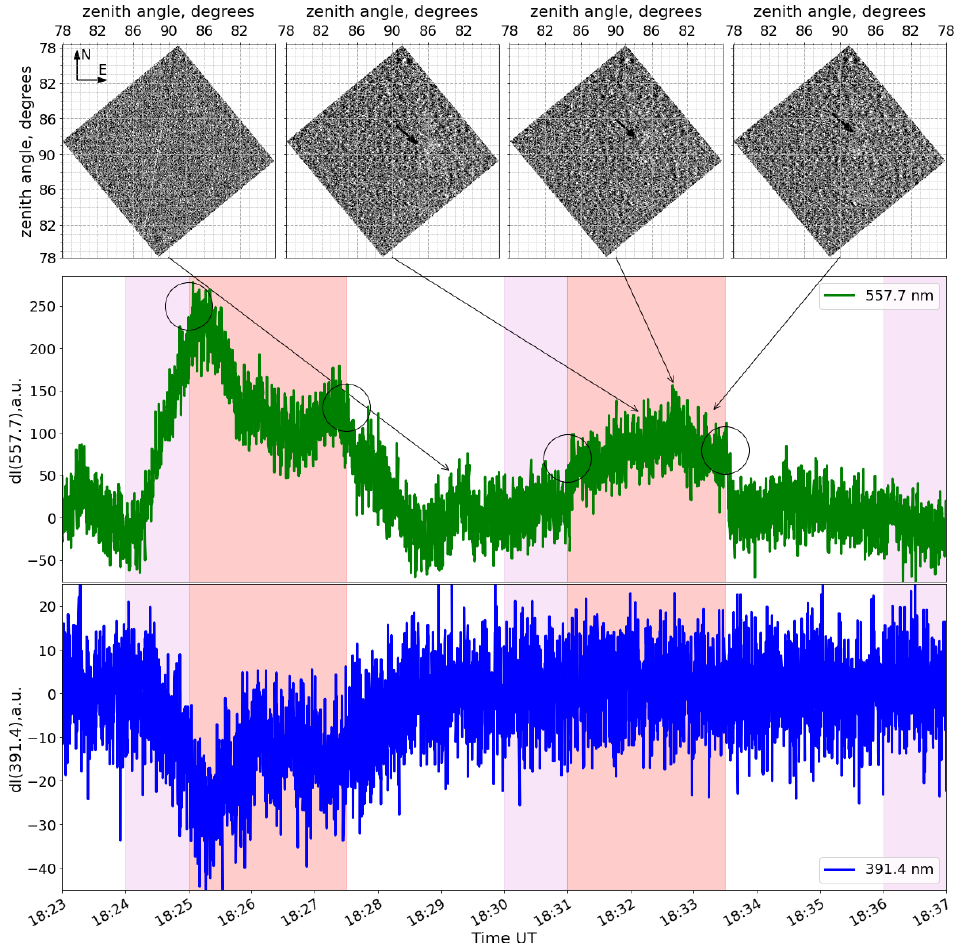
Figure 6. Photometric curves of ionospheric airglow at the 557.7 ( middle panel ) and 391.4nm ( low panel ) obtained on 5 September 2021. The pumping mode is shown by colored rectangles. The ( top panel ) shows the CCD camera frames at 557.7nm. The time moments for these on the ( upper panel ) frames are shown by arrows drawn to the curve in the (middle panel ). The black arrows on the top panel show the luminous